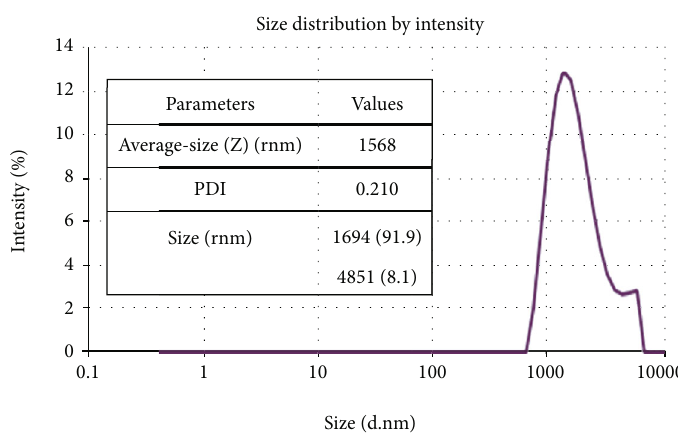
Figure 3: Particle size distribution of calcium zeolite particles.